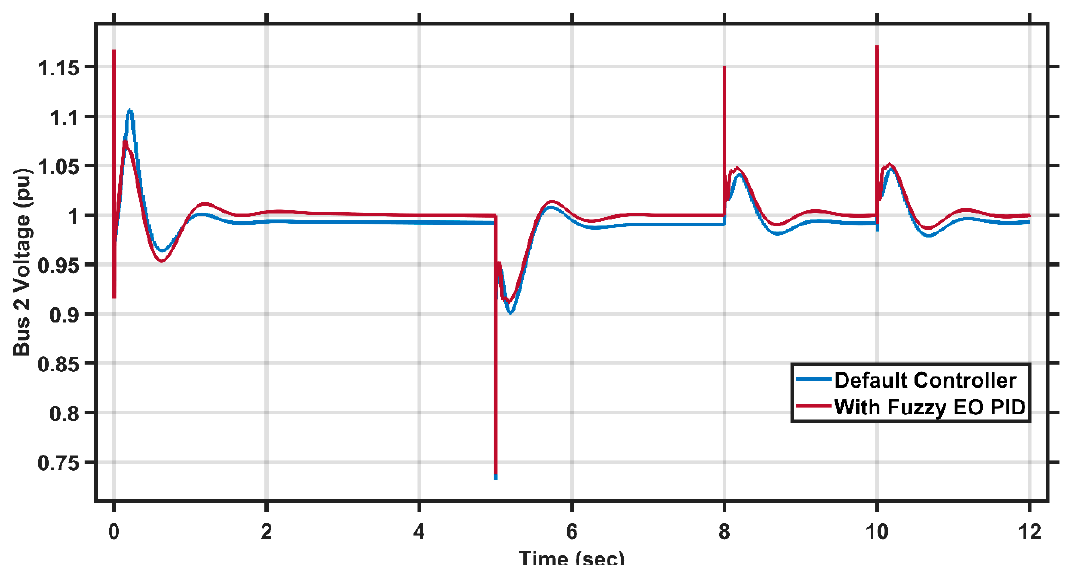
Figure 24. Bus 2 voltage at dynamic loading condition for the IEEE 9-bus system.